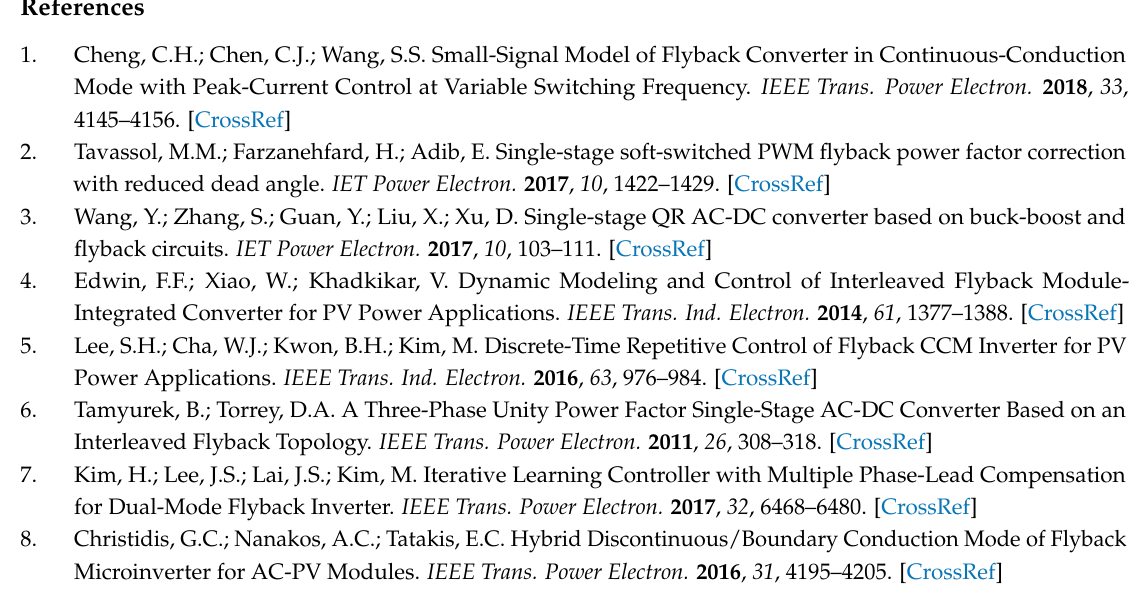
Figure 18. Output voltages when v ref steps from 15 V to 15.5 V. ( a ) SCB controller, ( b ) OSCB